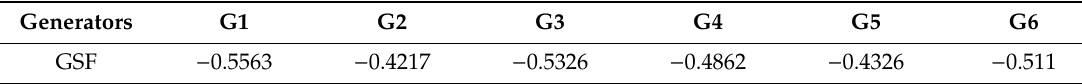
Figure 12. FPA-based suitable choice of PHSU for managing congestion. Table 8. Sensitivity factor without PHSU. Table 7. Sensitivity factor without PHSU.